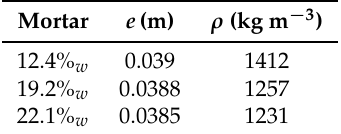
Table 2. Characteristics of the various